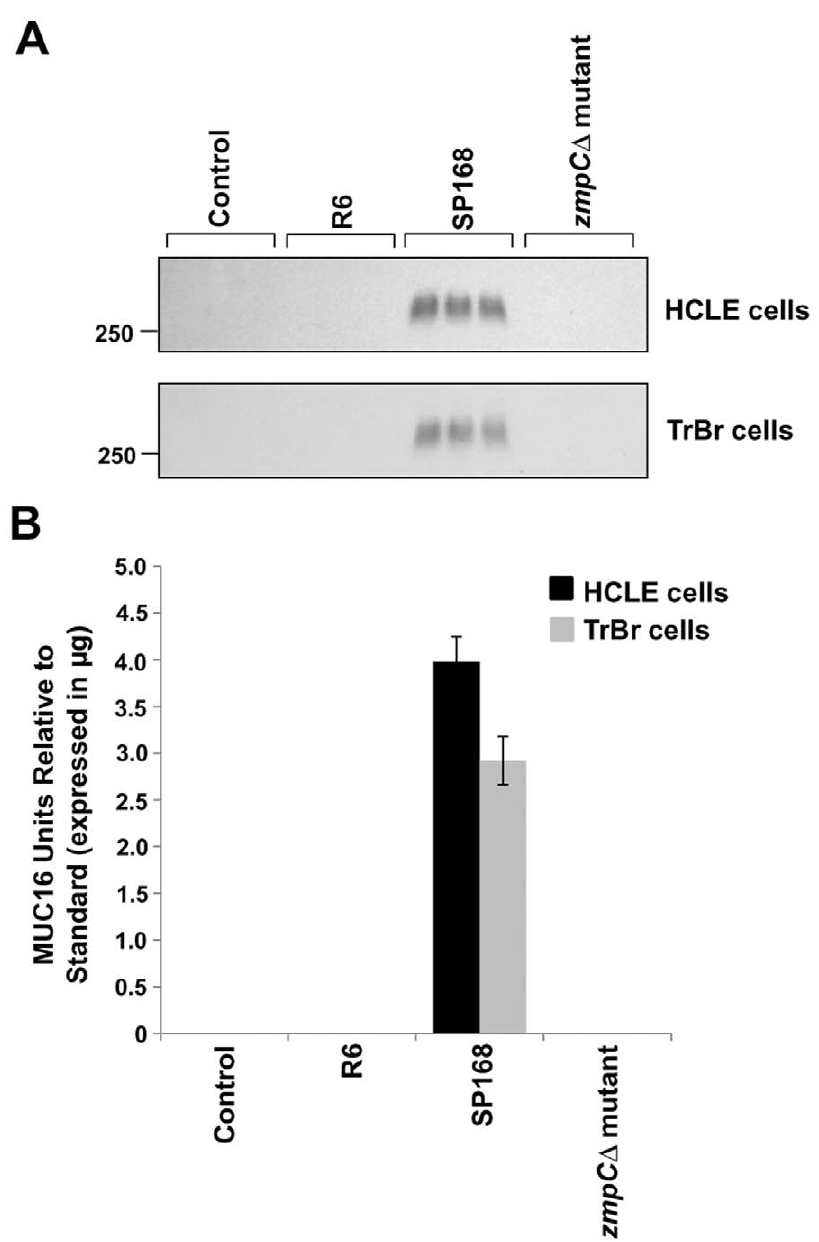
Figure 5. Epithelial MUC16 ectodomain release is induced by growth culture filtrate from SP168 but not from the SP168 zmpC D mutant. A ) Western blots using M11 antibody comparing the amount of shed MUC16 in cell culture supernatants recovered after exposure of stratified HCLE and TrBr cells to bacterial growth culture filtrates from strains R6, wild type SP168 and the SP168 zmpC D mutant. B ) Quantitative analyses of western blots in (A) show that the filtrate derived from the SP168 zmpC D mutant is unable to induce MUC16 ectodomain shedding in HCLE cells as well as in TrBr cells (n=3). All data are represented as MUC16 units relative to the standard 6 SEM.